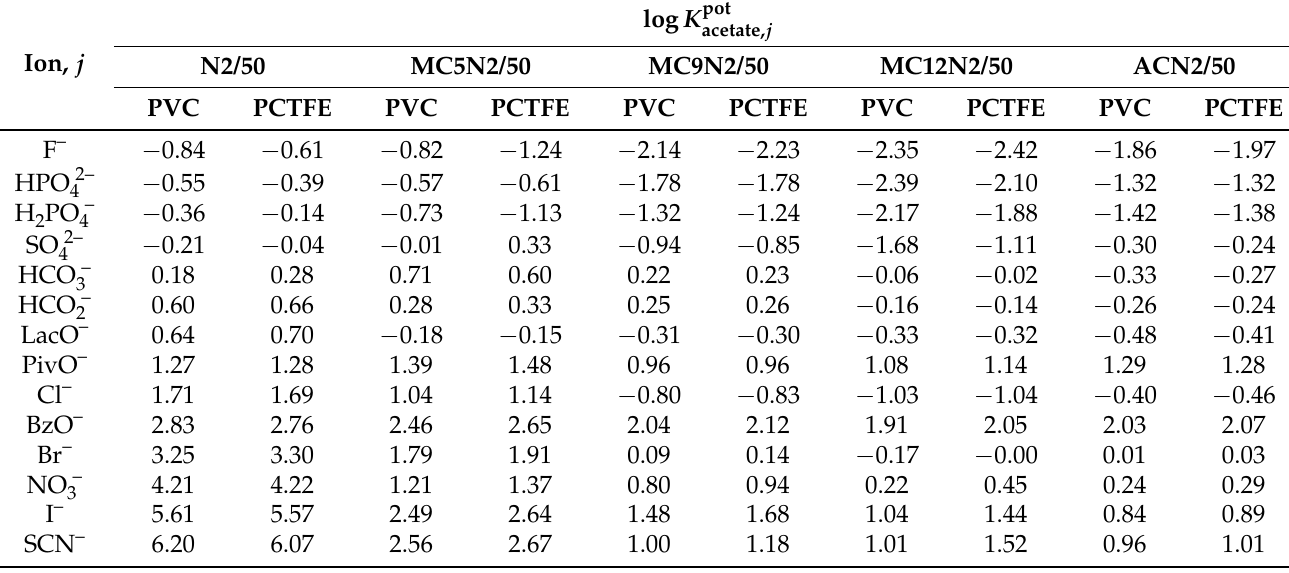
Table A9. Average potentiometric selectivity coefficients determined with the separate solution method ( a i = a j = 10 − 2.05 M) for sensors with membranes containing 2wt.% ionophore, 50mol.% (relative to the ionophore) TDMACl, and o -NPOE as the plasticizer. The number of measurements and the number of sensors were n = 1 and k = 2, respectively. See Table A10 for standard deviations. See Table 1 for membrane compositions.